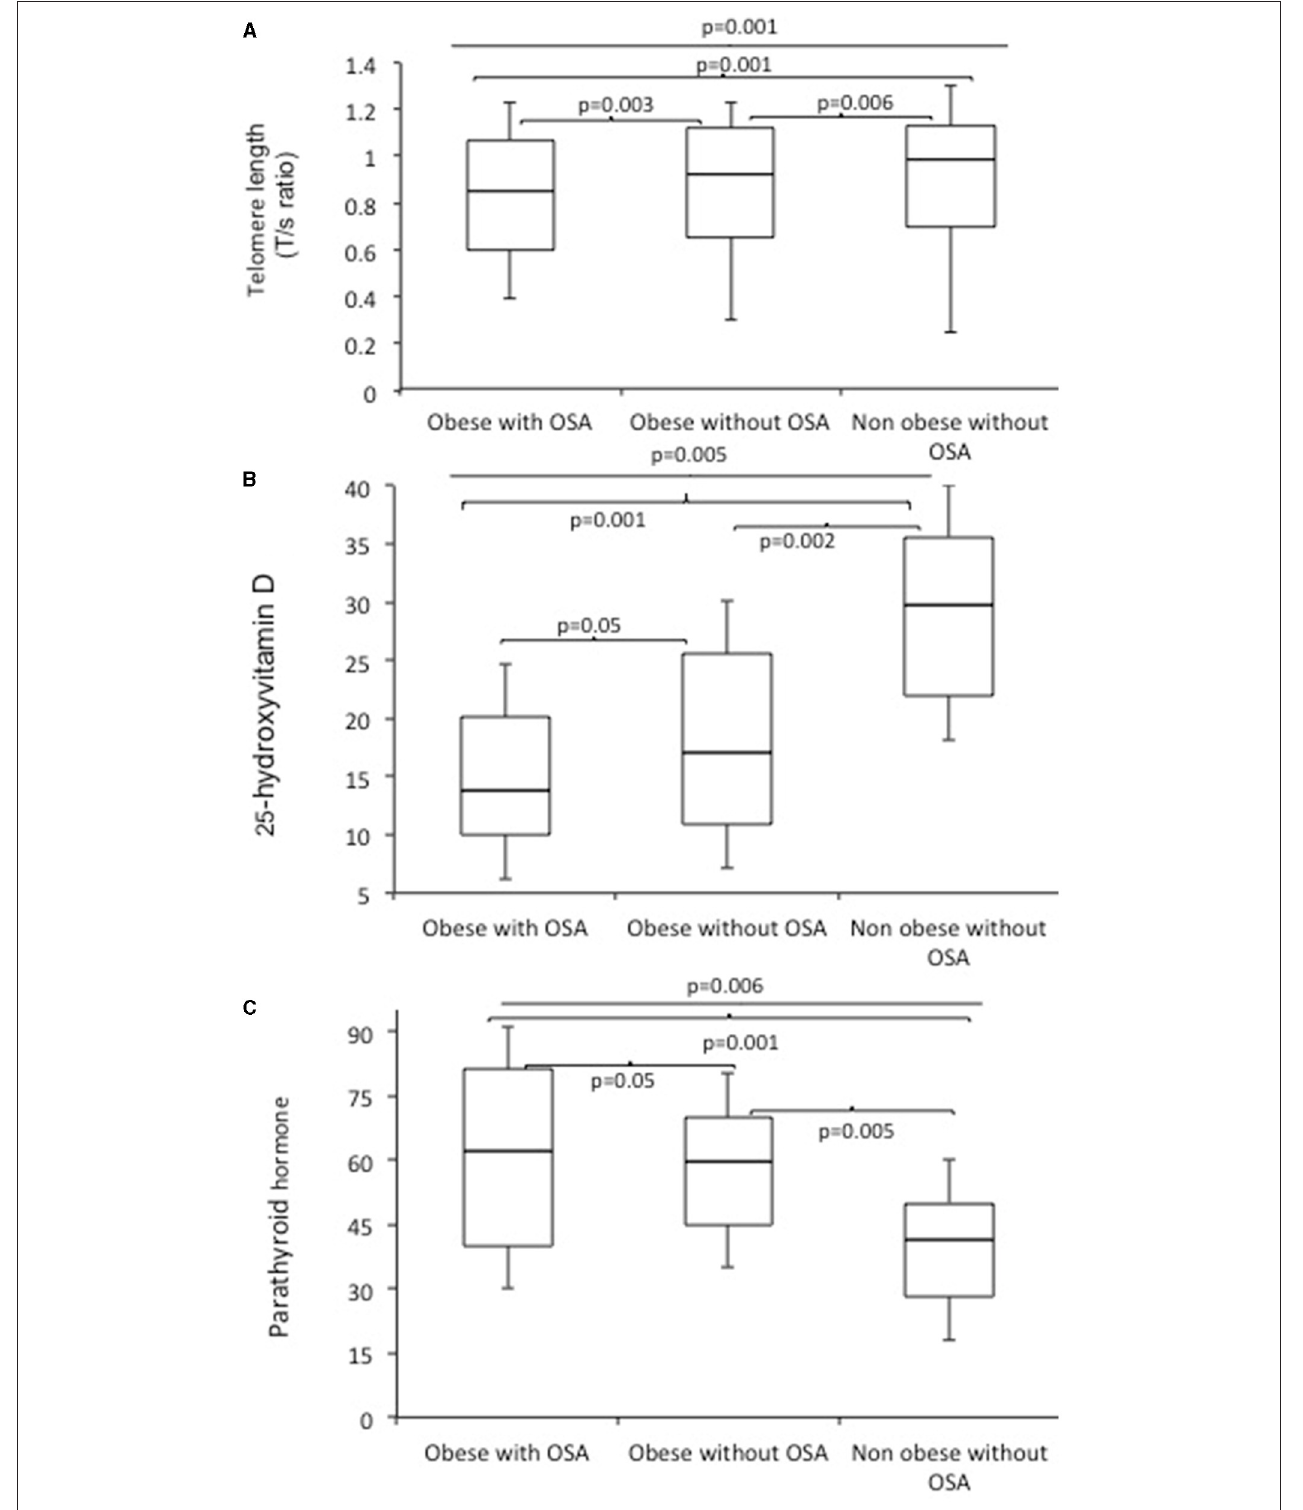
FIGURE 1 | Boxplots of telomerase length (T/S ratio) (A) , 25 hydroxy vitamin D (B) , and serum parathyroid hormones levels (C) in obese subjects with OSA, obese subjects without OSA, and non-obese subjects without OSA.